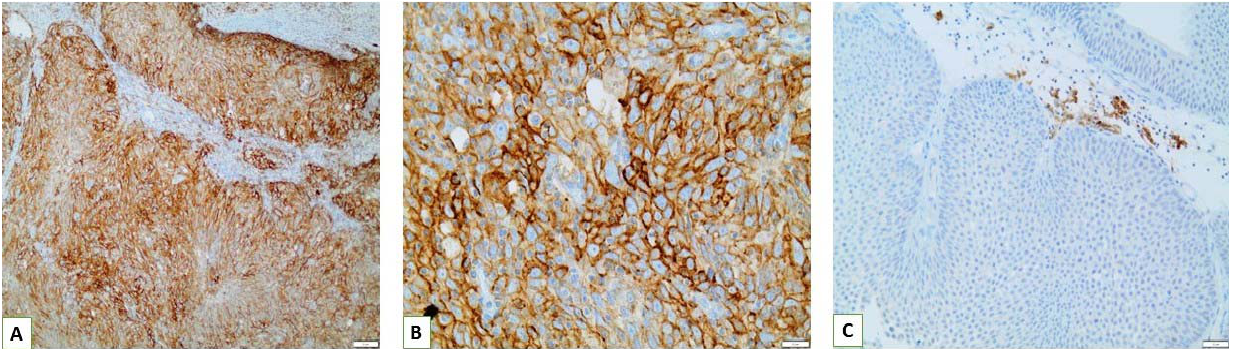
Figure 7. ( A , B ) Strong positive PD ‐ L1 membranous expression in tumor cells of a basal type MIBC (×200, ×400); ( C ) Strong positive membranous expression of PD ‐ L1 in immune cells present in the contiguous peritumoral stroma of pTa NMIBC (×200 ) .